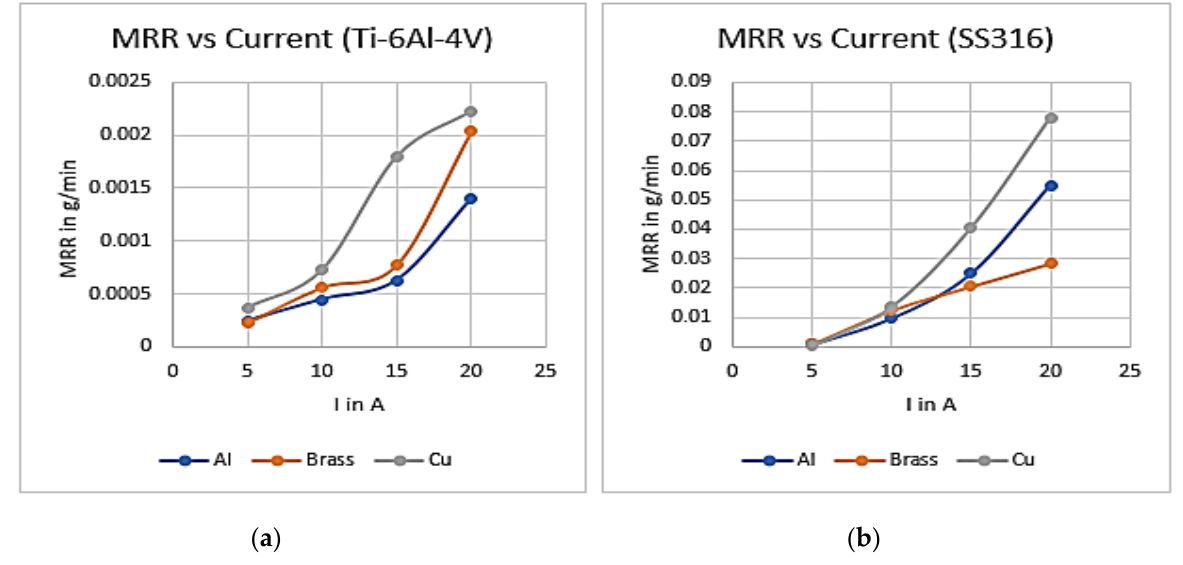
Figure 7. Variations of MRR for ( a ) Ti-6Al-4V and ( b ) SS316 using different tools.